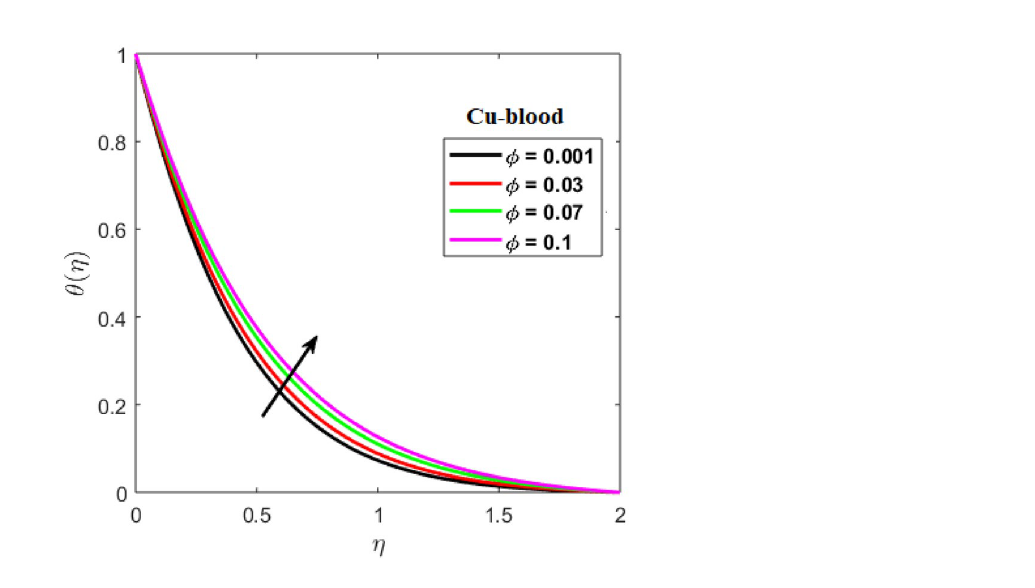
Figure 6. Results of φ on